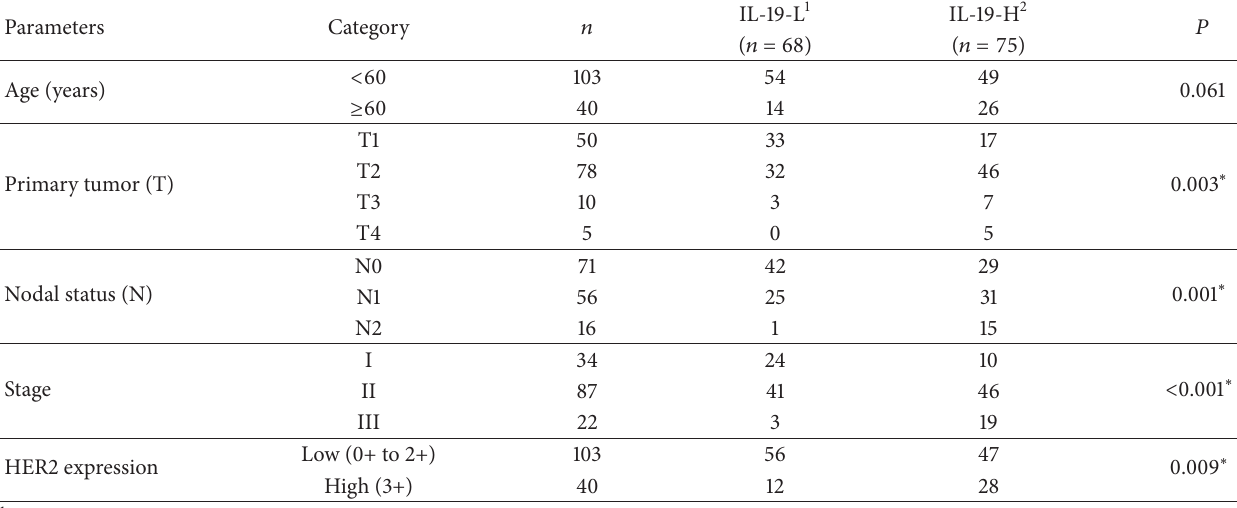
Table 2: Associations between IL-19 expression in 143 breast invasive duct carcinoma tumors with other important clinicopathologic variables.